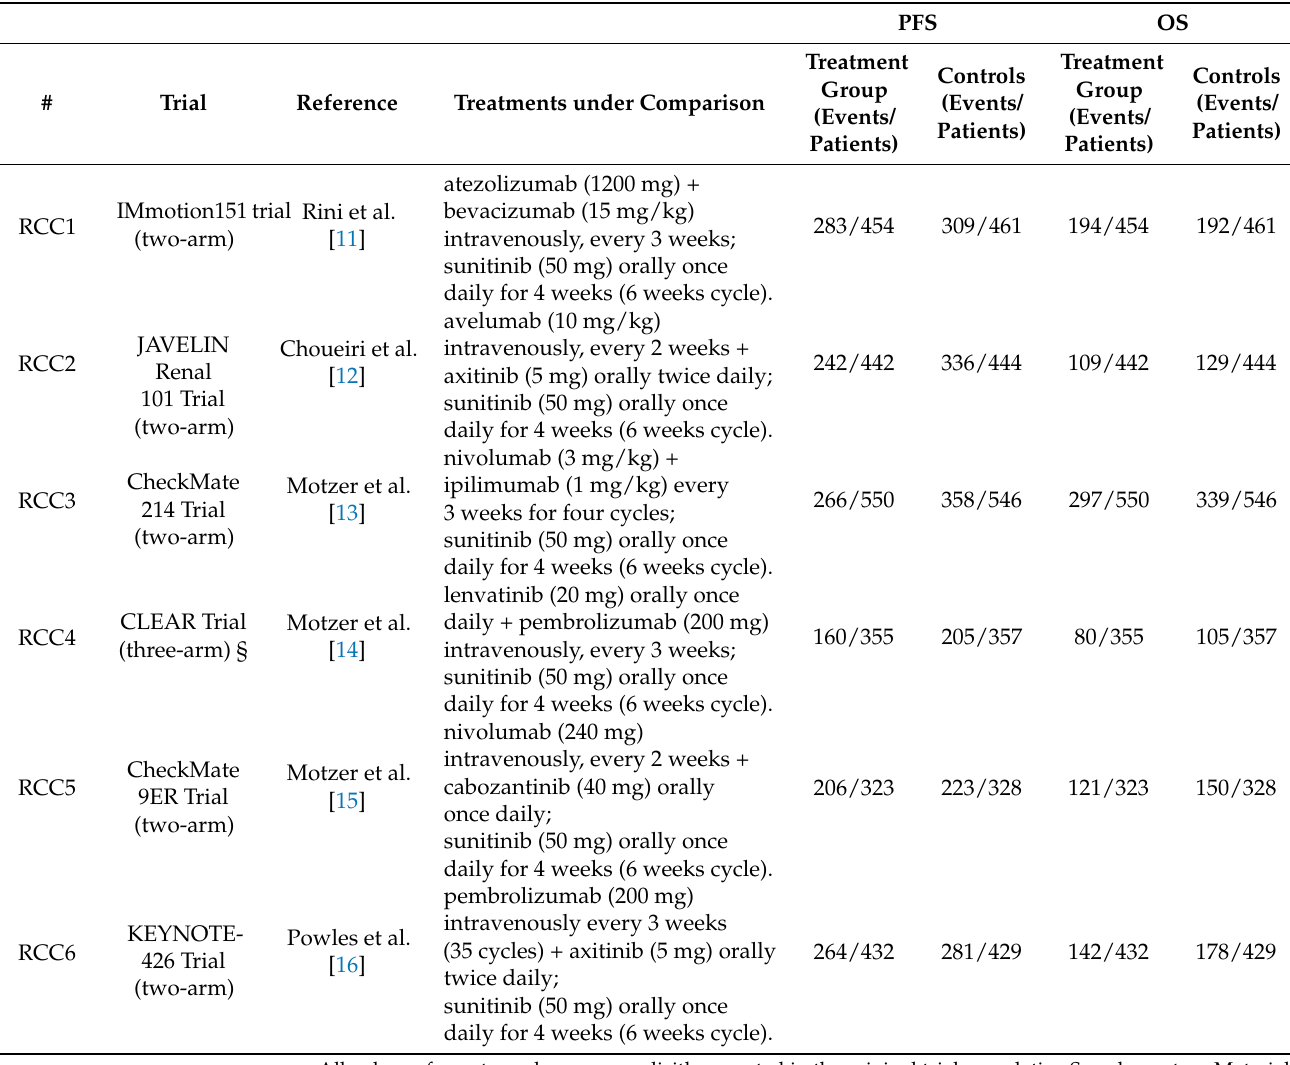
Table 1. Main information about the 6 RCTs included in the analysis.